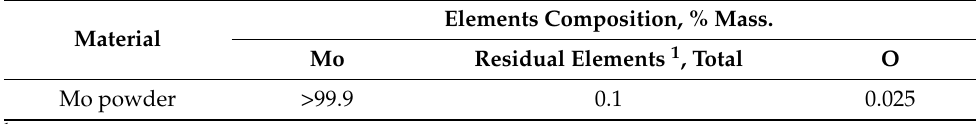
Table 2. The chemical composition of the 25L steel substrate. Elements Composition, % Mass. Material Fe C Mn Si